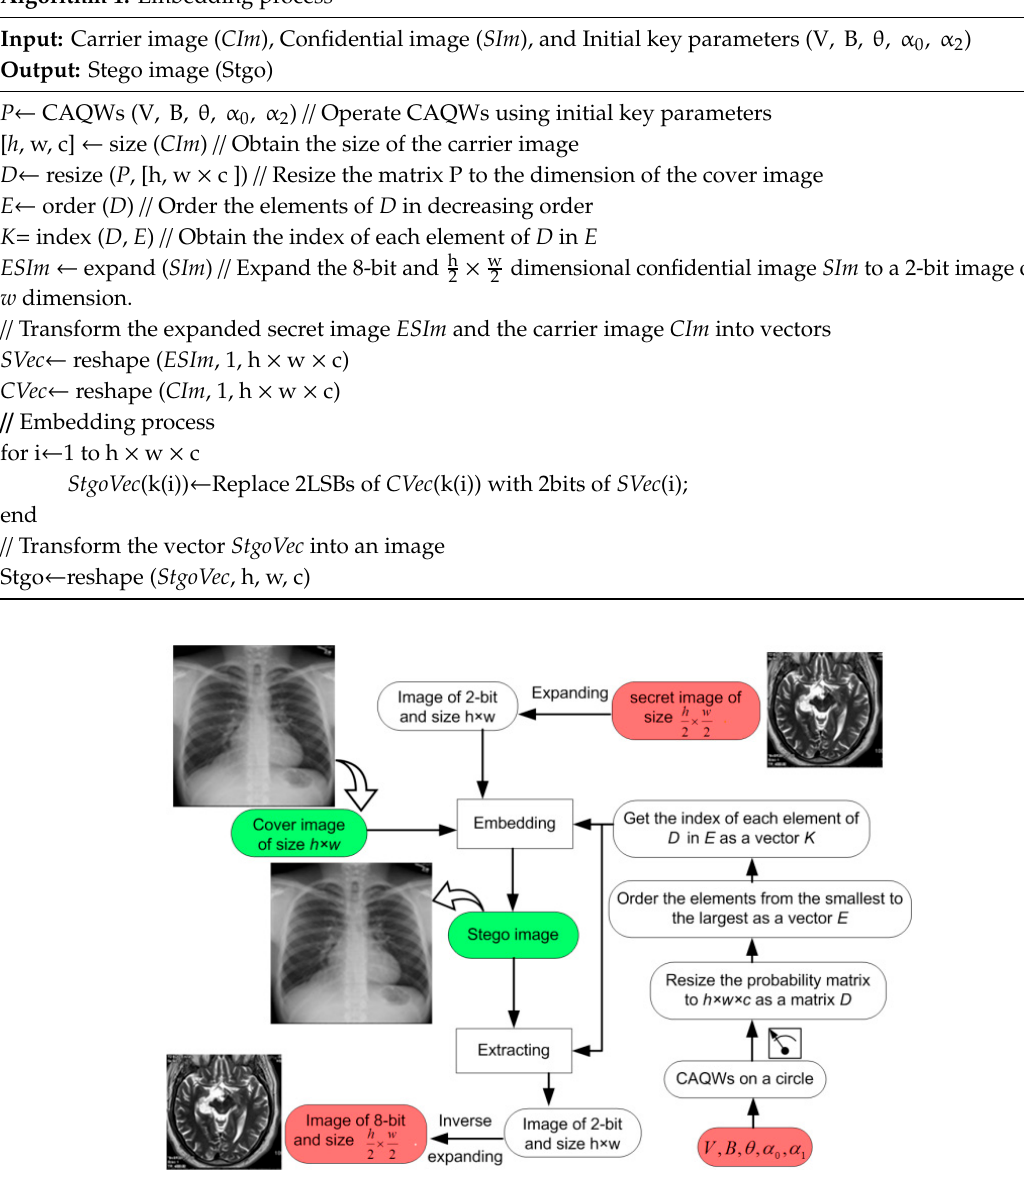
Figure 2. Outline of the proposed image stego scheme.